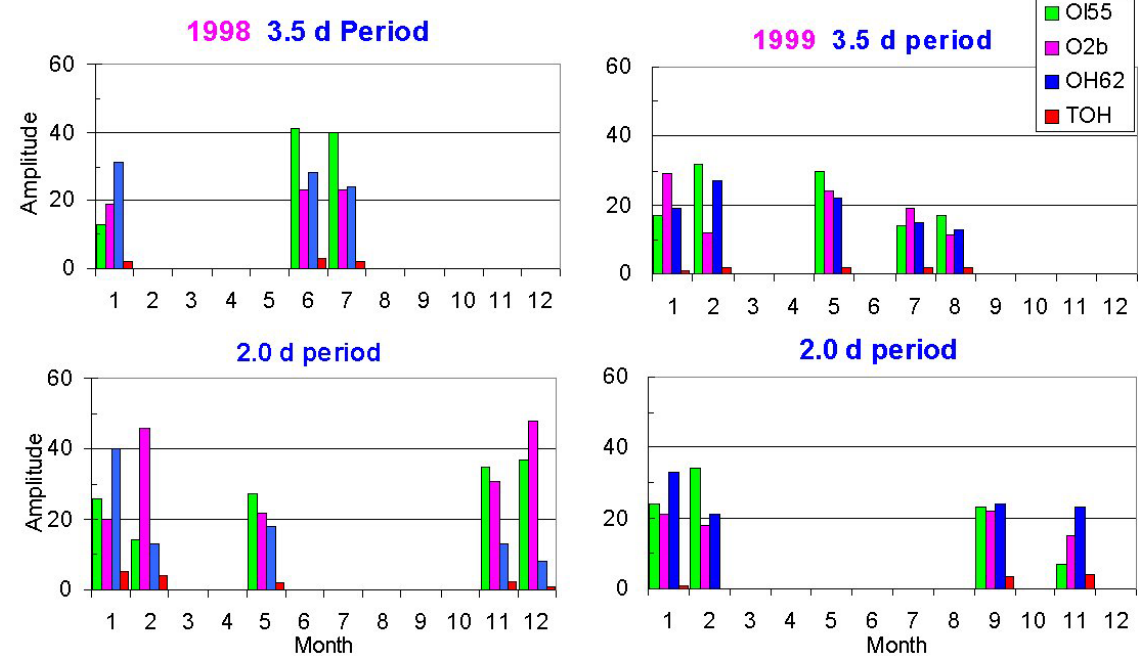
Fig. 12. Two- and 3.5-day waves seen in airglow emissions observed at S˜ao Jo˜ao do Cariri (6 ◦ S) (Takahashi, personal